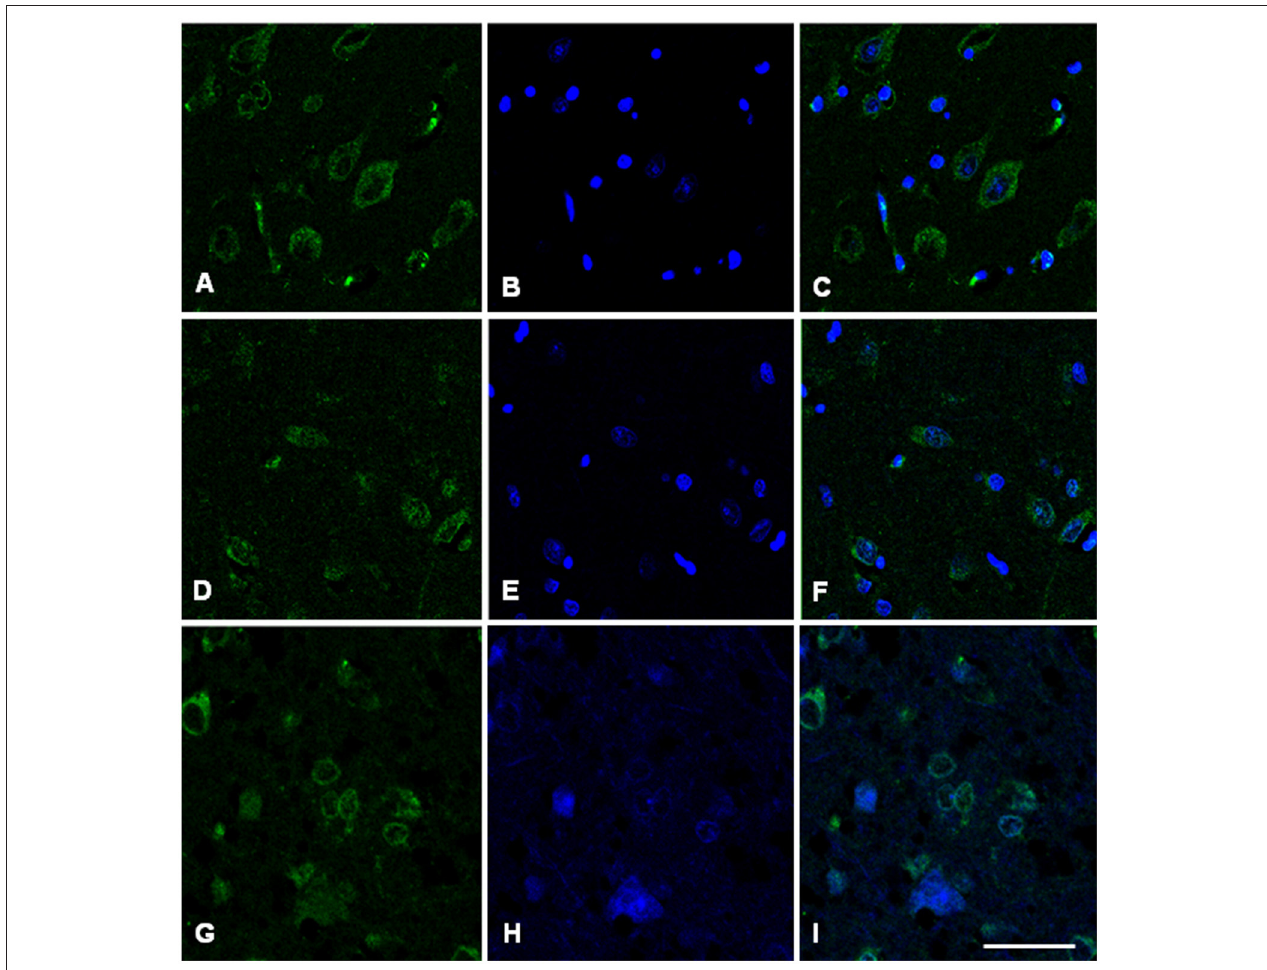
FIGURE 8 | Hemoglobin alpha-chain in the frontal cortex of control subject (A–C) , Alzheimer’s disease (D–F) and sCJD (G–I). Immunofluorescence and confocal microscopy for hemoglobin α -chain (A,D,G) and nuclei (B,E,H) showing hemoglobin immunoreactivity in neurons of AD patients (F, I merge) compared to control (C, merge). Nuclei stained with DRAQ5 TM . Bar = 50 µ